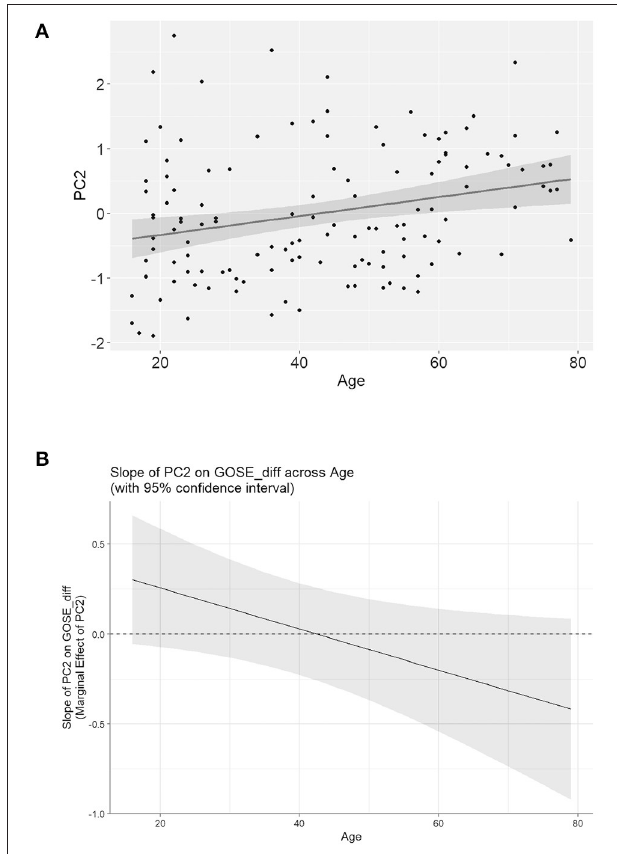
FIGURE 6 | Age moderates the effect of inflammation on outcome after TBI. (A) Age significantly predicts inflammatory PC score ( R 2 = 0.062, p < 0.01), indicating greater multivariate inflammatory protein expression as age increases. (B) Visualization of the interaction between age and inflammation on improvement in GOS-E score from 3 to 6 months post-injury. The Y-axis represents the slope value of the effect of inflammatory PC2 score on change in GOS-E score. The negative relationship between slope value and age indicates that as age increases, the relationship between inflammation and improvement in recovery becomes more negative. This finding suggests a more detrimental relationship between inflammation and recovery for older TBI